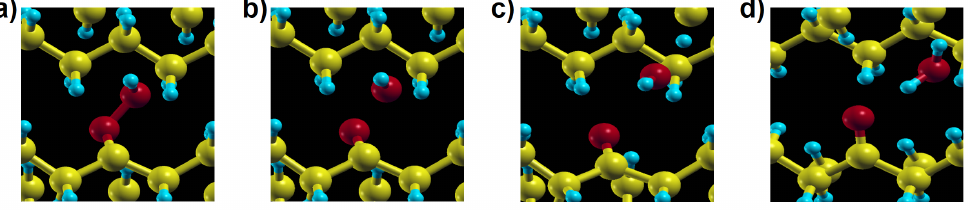
Figure 6. The four snapshots ( a – d ) are representative steps of the relaxation from an (unstable) α -alkyl-hydroperoxy radical to the endpoint of reaction 3c in crystalline